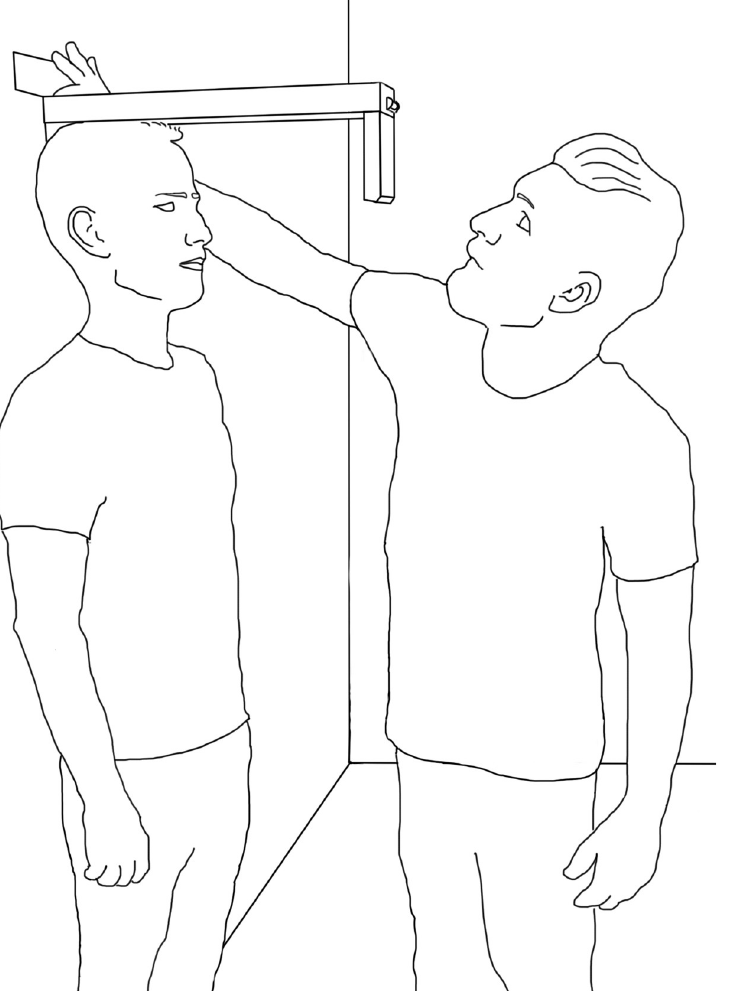
Fig 2. Demonstration of how to use the laser height